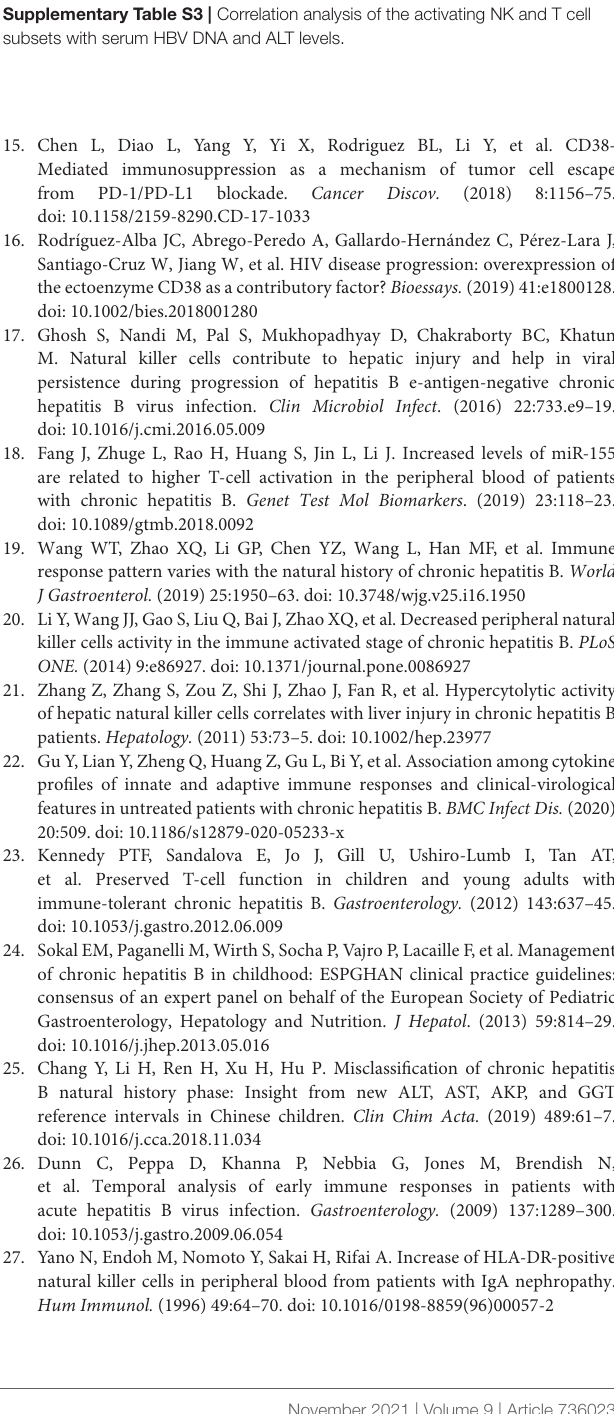
Supplementary Figure S2 | Representative flow plots of the gating strategy used for phenotype assessment of NK cells. Supplementary Figure S3 | Representative flow plots of the gating strategy used for phenotype assessment of T cells. Supplementary Figure S4 | Representative flow plots of the gating strategy used for functionality assessment of NK cells and CD8 + T cells. Supplementary Table S1 | Univariate and multivariate analysis of variables associated with clinical phases (IA phase vs. IT phase) in CHB children. Supplementary Table S2 | Comparison of immune characteristics between gray zone and strict IT phase. Supplementary Table S3 | Correlation analysis of the activating NK and T cell subsets with serum HBV DNA and ALT